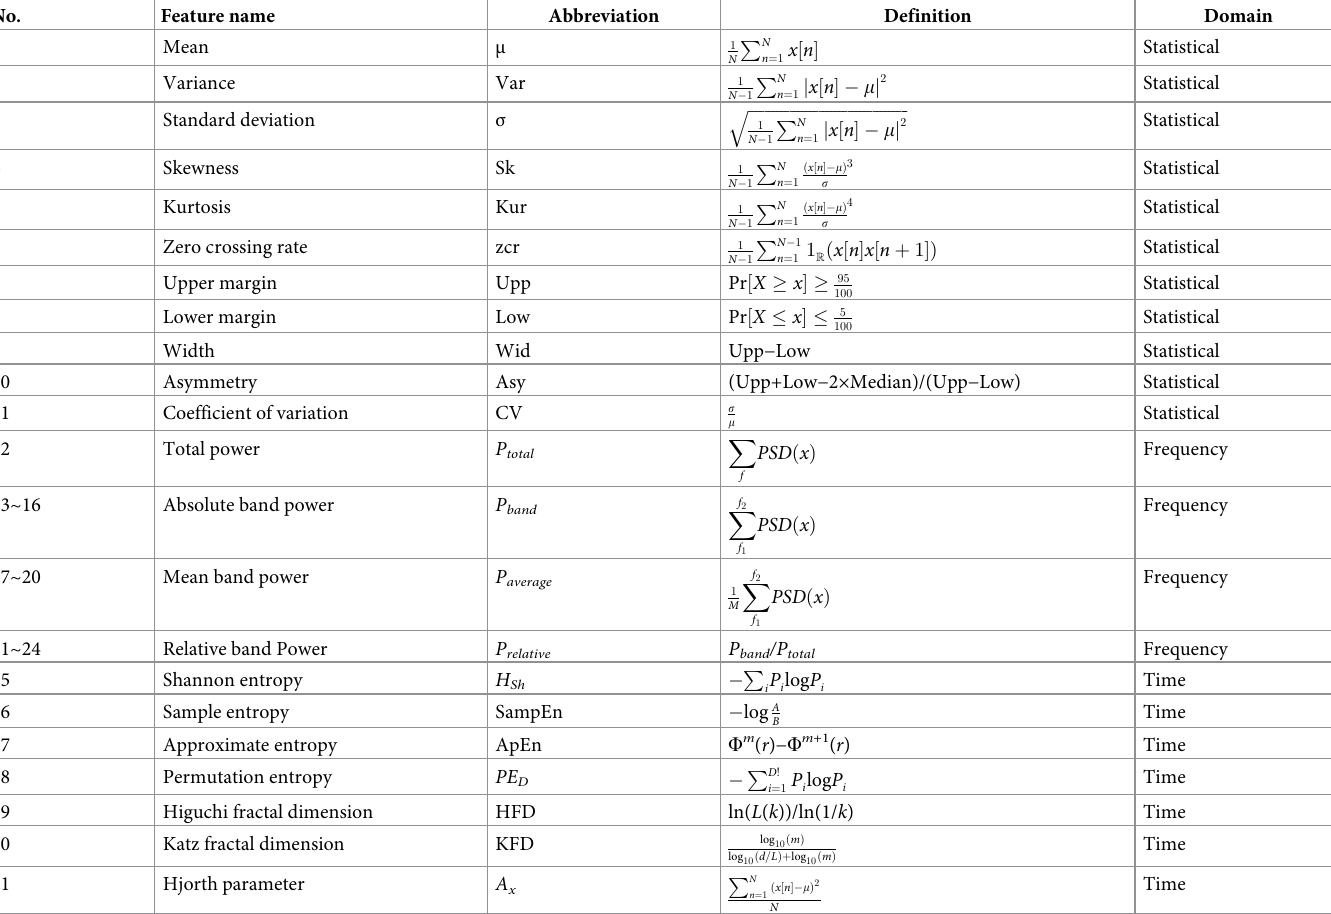
Table 1. Summary of conventional EEG features obtained for patients diagnosed with schizophrenia and healthy (control) subjects.